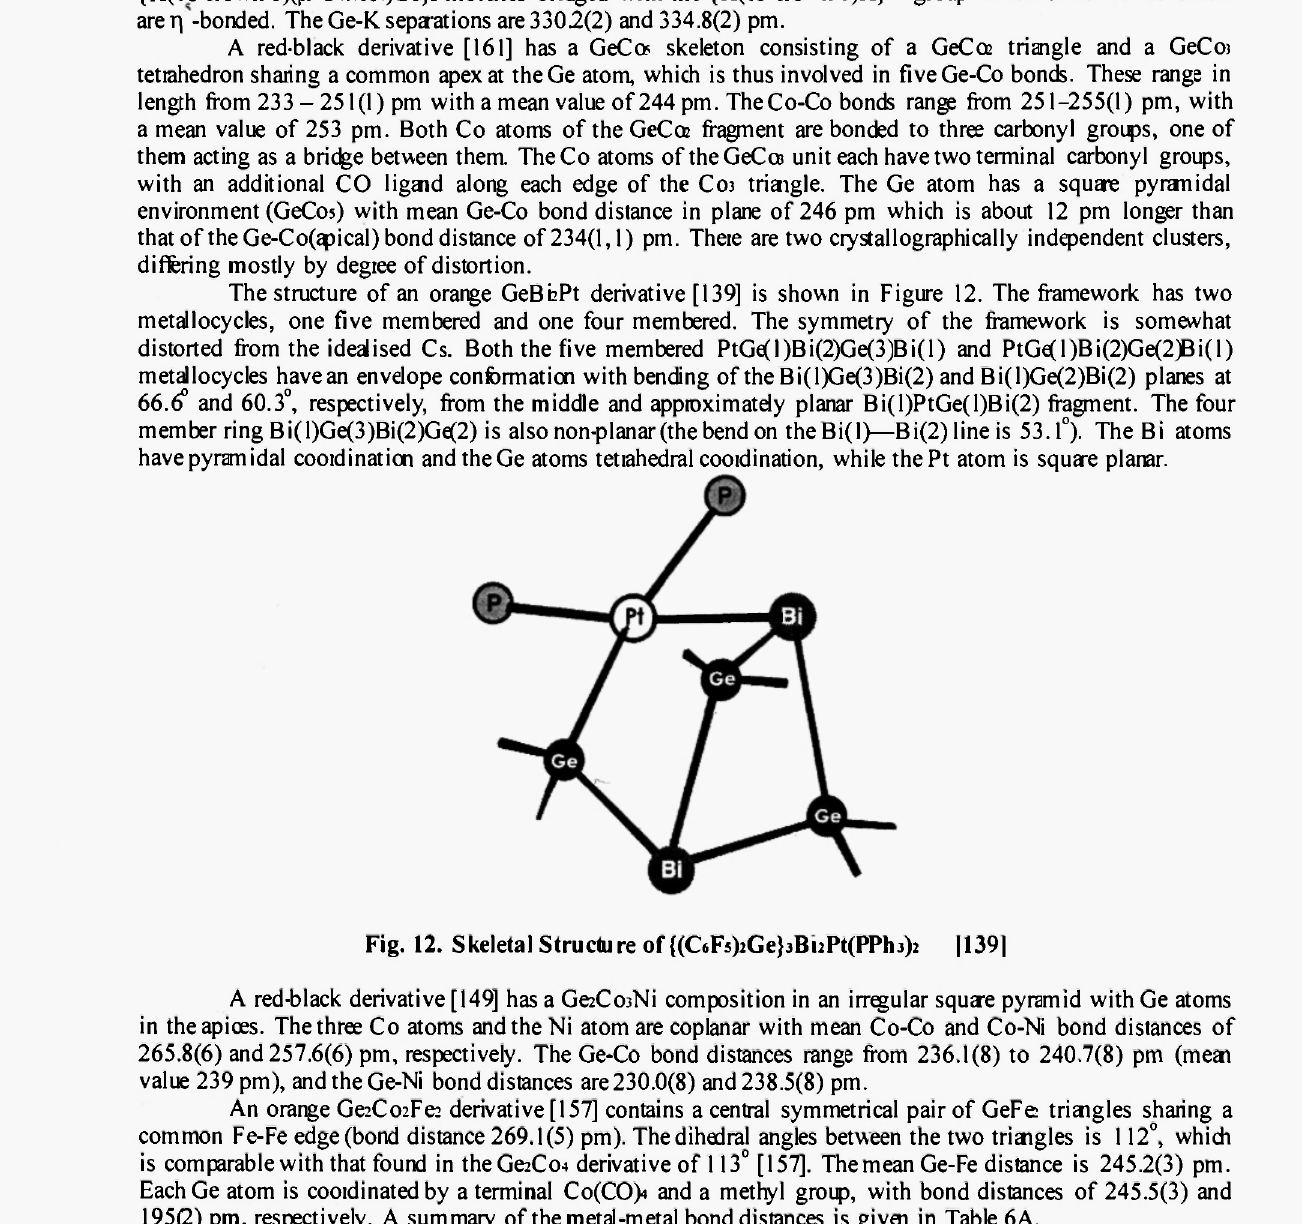
Table 6A Summary ofGe-Mand M-M Distances in Heterohexameric Germanium